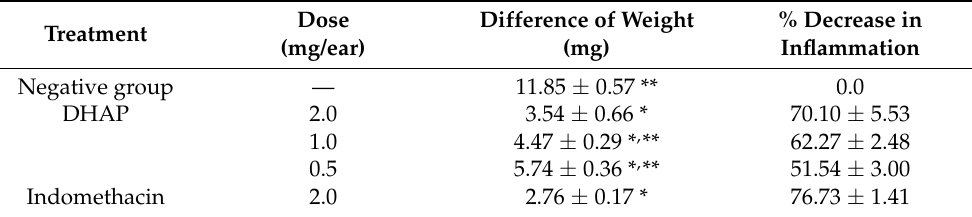
Table 1. Anti-inflammatory activity of DHAP on ear edema induced by TPA in